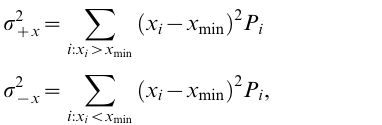
Figure S1 Calibration of IPTG levels against MarA levels. The data (boxes) are well-described by Eq. (6) (line). Figure S2 Fit of the recruitment model to CRP-dependent activity of the lac promoter. The data were generated using a Hill equation based on previously measured promoter activity data from Ref. [15], and the error bars were arbitrarily assigned for the fitting. Table S1 Promoter activity data. Text S1 Equation for the free polymerase concentration obtained by solving Eqs. (4) in the text. (It is a complex expression, but evaluates to a real number for parameter values used in this study). Found at: doi:10.1371/journal.pcbi.1000614.s004 (0.03 MB